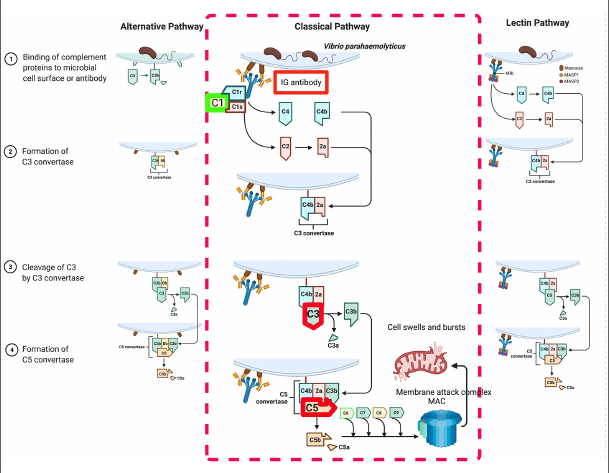
FIGURE 8 | A theoretical model of the host response to exogenous V. parahaemolyticus infection.